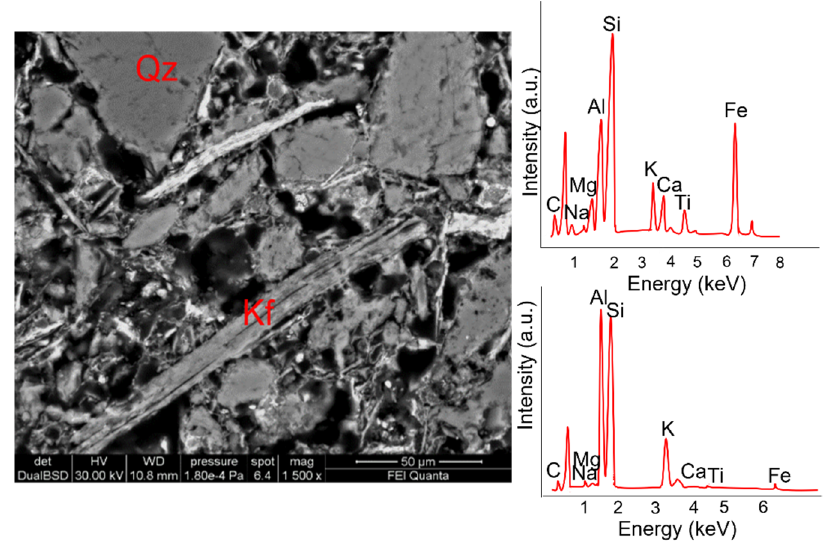
Figure 6. SEM image and EDS spectra of amphibole (upper spectrum on the right) and clay mineral (lower spectrum on the right) referred to sample B4 (red brick).